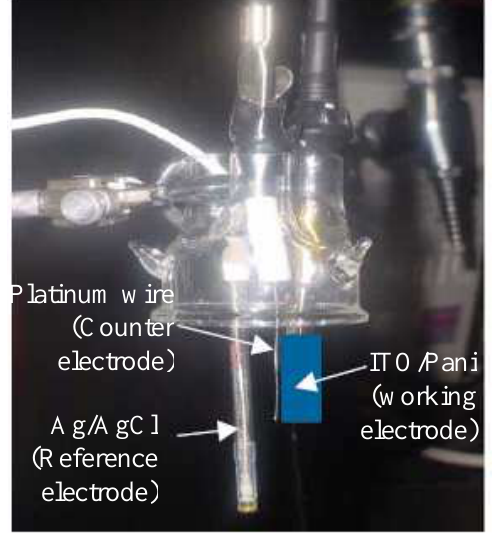
Figure 8. ITO-Pani